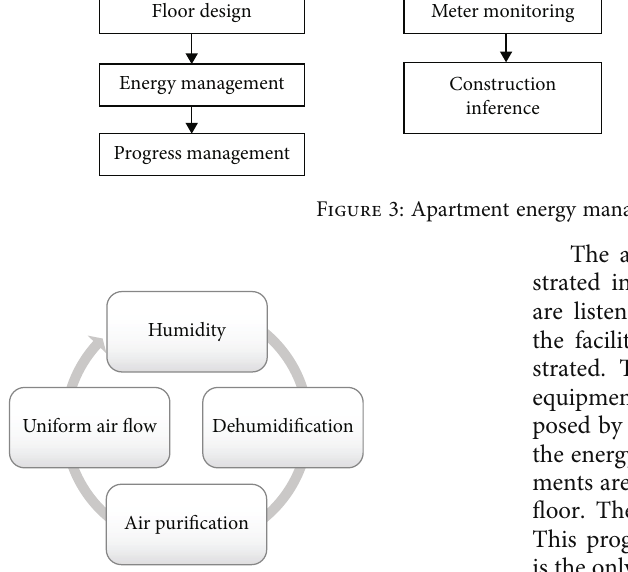
Figure 4: Construction of energy-e ffi cient